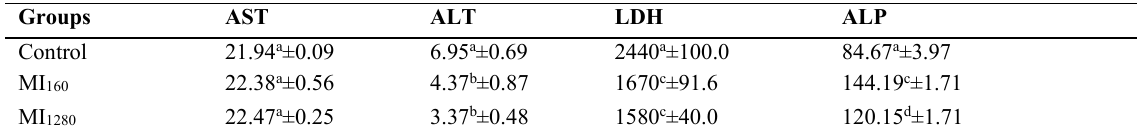
Table 5. Mean activity (IU/L) of AST, ALT, LDH and ALP in BMSCs after 36 hours of treatment with myo- inositol. Groups AST